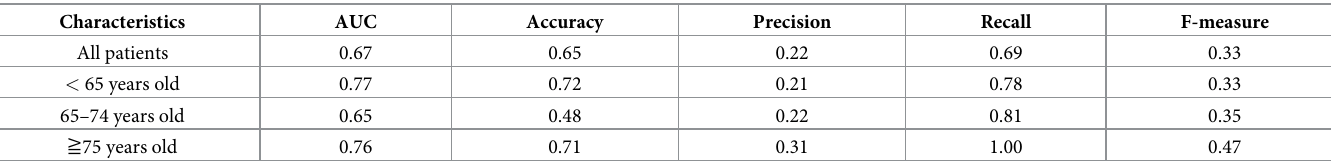
Table 2. Model performance for predicting Cis-AKI.